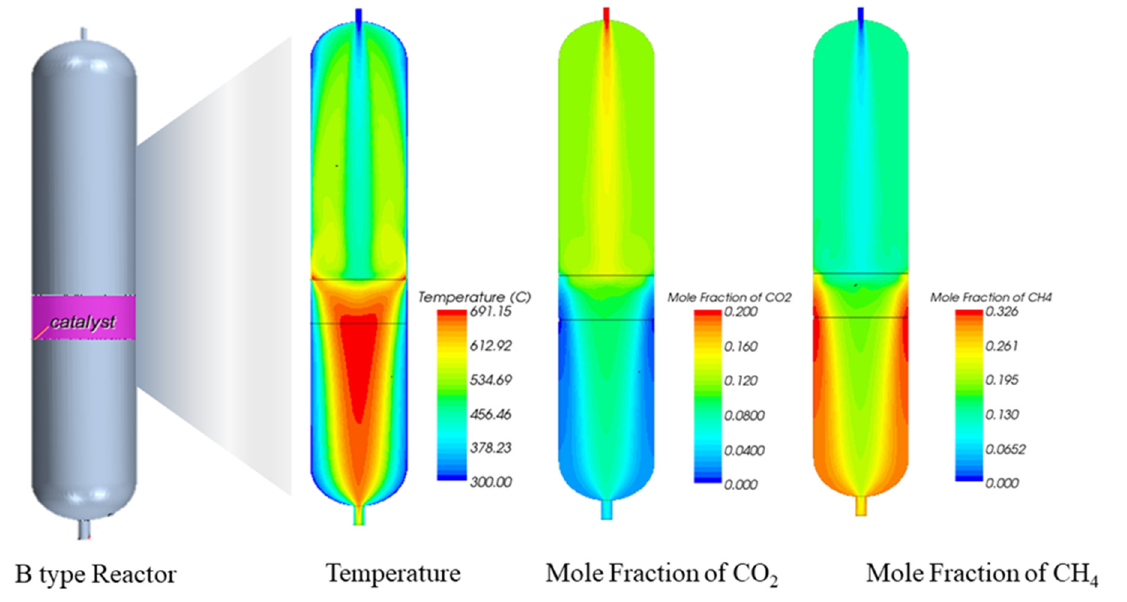
Figure 2. Reacting flow simulation for the A-type reactor.